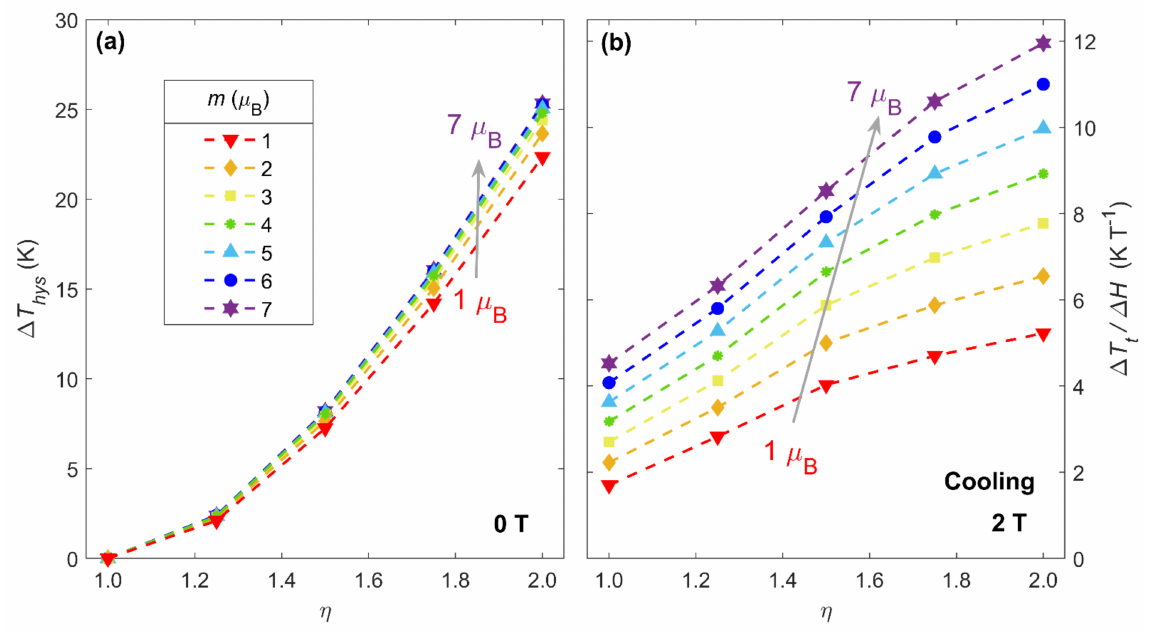
Figure 4. ( a ) Thermal hysteresis at zero field and ( b ) magnetic field evolution of the transition temperature (cooling branch) as a function of η and m